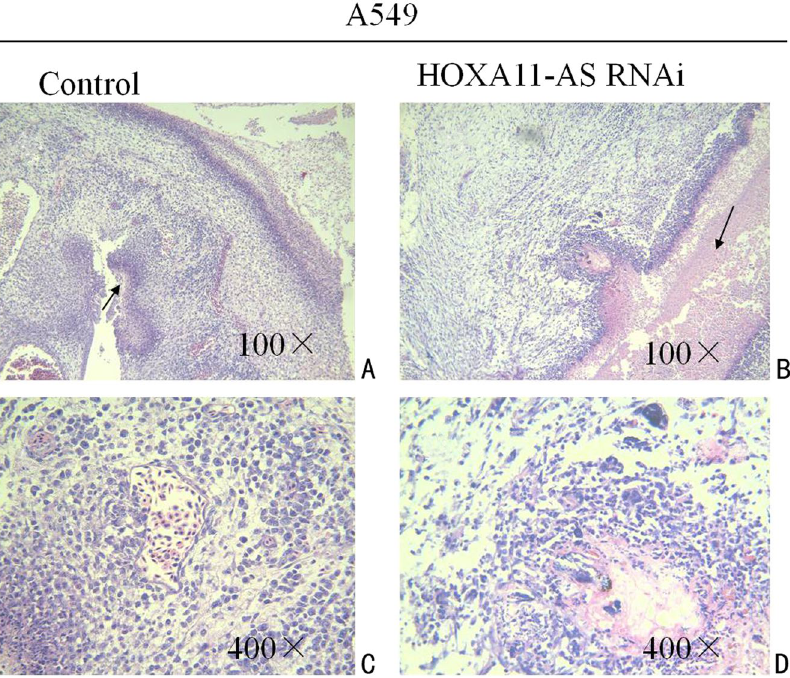
Figure 12. Hematoxylin/eosin (HE) staining of the tumor xenografts. ( A ) Hematoxylin/eosin (HE) staining of the tumor xenografts in the lenti-control virus group (100 × ). ( B ) Hematoxylin/eosin (HE) staining of the tumor xenografts in the HOXA11-AS RNAi group (100 × ). ( C ) Hematoxylin/eosin (HE) staining of the tumor xenografts in the lenti-control virus group (400 × ). ( D ) Hematoxylin/eosin (HE) staining of the tumor xenografts in the HOXA11-AS RNAi group (400 ×